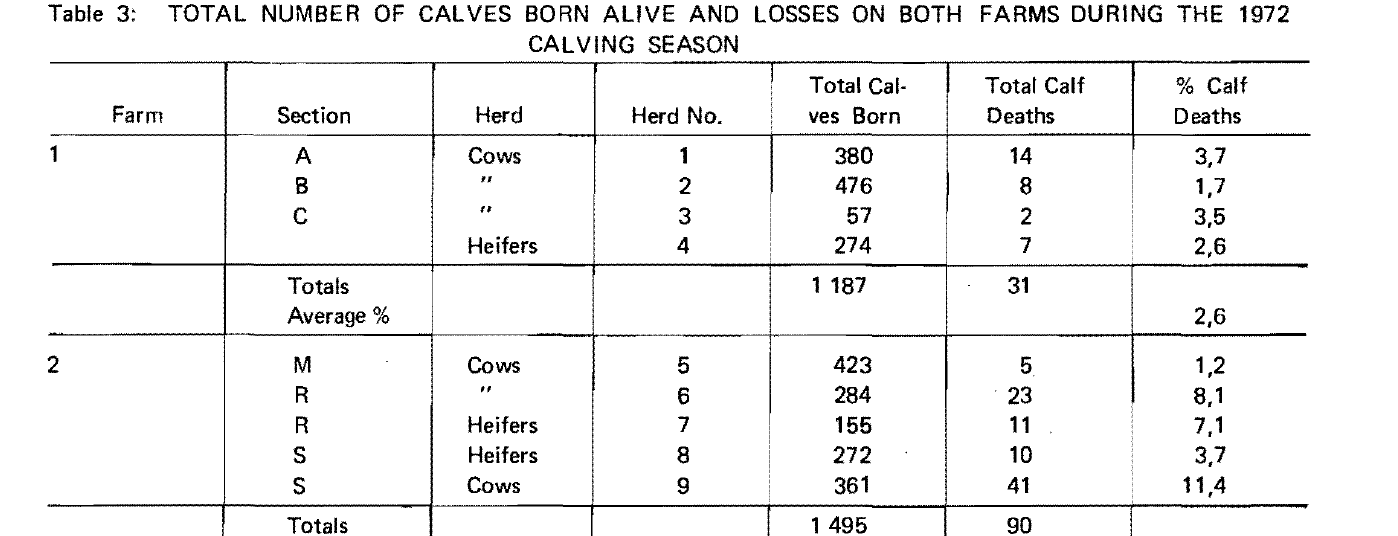
PRE·NATAL AND POST·NATAL LOSSES WHICH OCCURRED DURING 1972 ON FARM 2, SECTION ,"S" % %